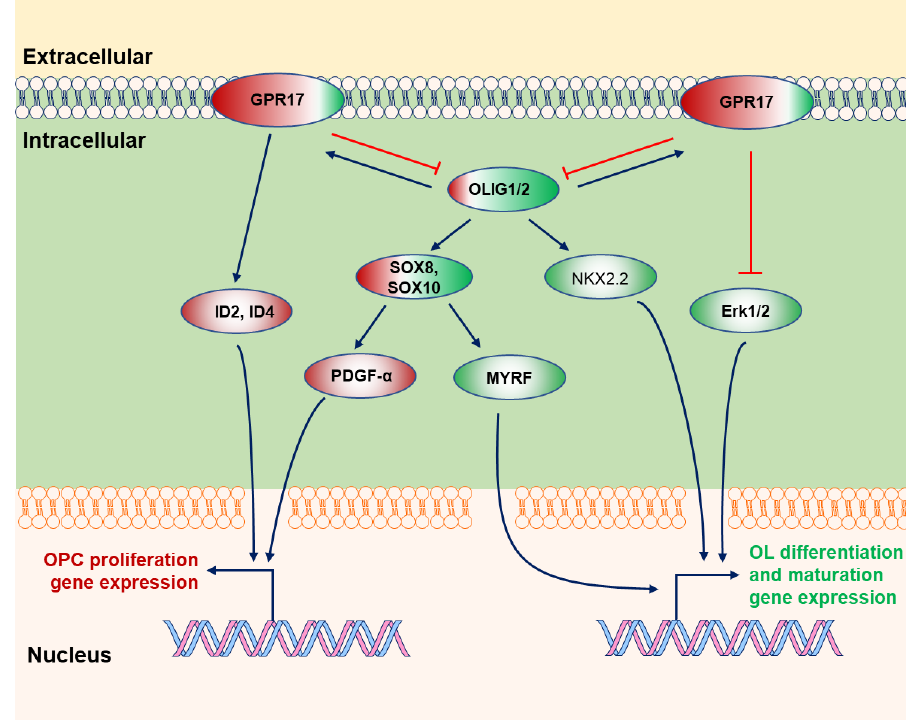
Figure 4. GPR17 promotes OPC proliferation and OLIG1/2 mainly induces OL differentiation. OLIG2 modulates Gpr17 expression, and GPR17 acts as a negative feedback factor to Olig1/2 expression. GPR17 mainly promotes OPC proliferation with inhibition in OL differentiation via ERK1/2. OLIG1/2 are the markers for OL family cells and have multiple roles in OL myelination via different downstream factors. Genes in the ellipse with different colors: the red color stands for the genes involved in OPC proliferation, and the green color refers to those correcting with OL differentiation and maturation. Different ratios of red and green in the ellipse imply the genes’ potential ratio in multiple processes. The sign of blue arrows represents promoting, and the sign of red lines represents